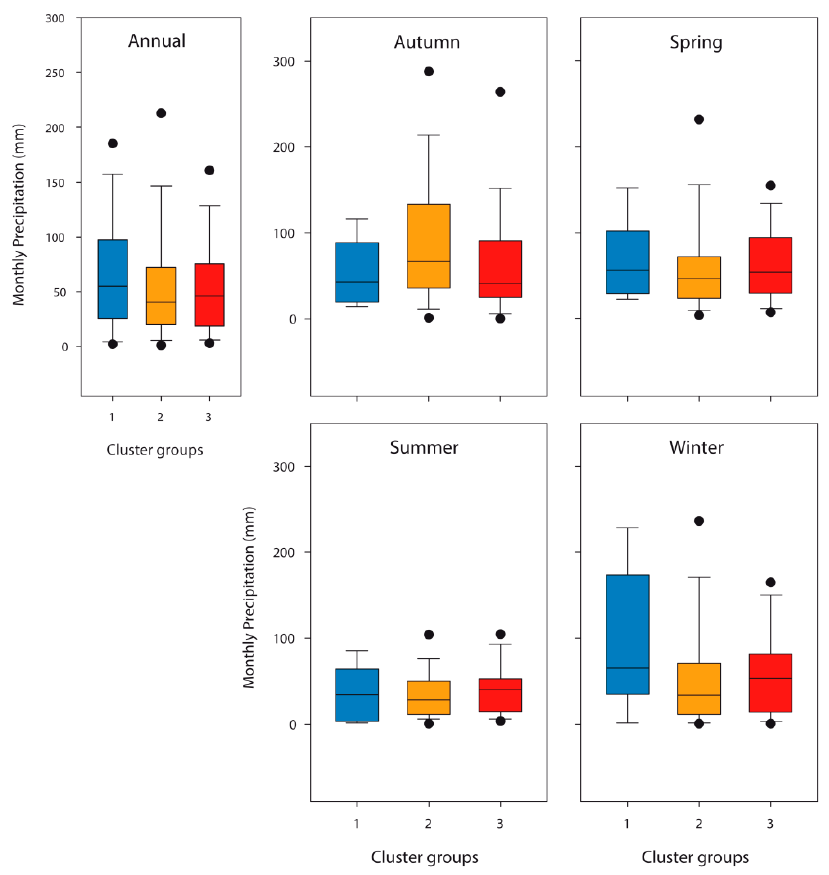
Figure 10. Annual and seasonal rainfall distributed yearly according to the different cluster groups.